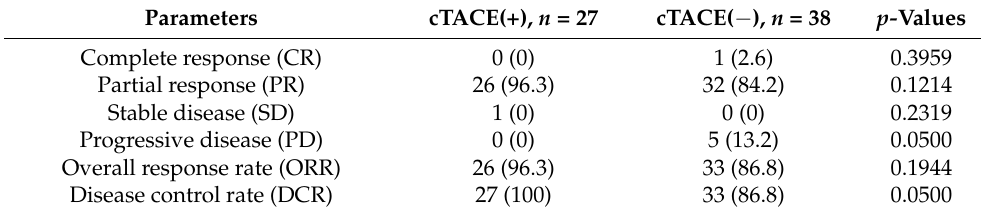
Table 2. Treatment response to first DEB-TACE.